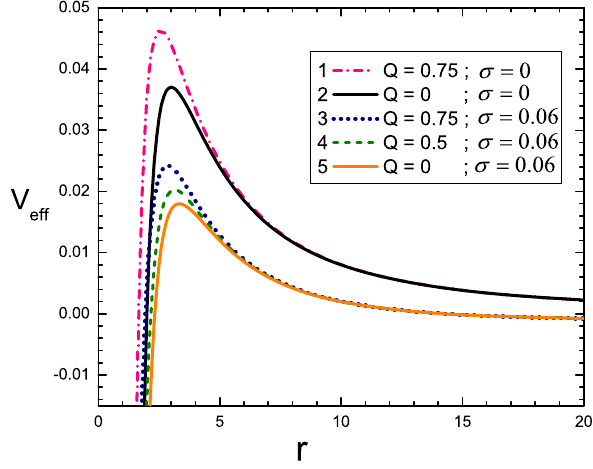
Fig. 3 Effective potential V eff is shown as a function of distance r for non-extreme case at a different values of charge Q with constant value , second curve of quintessence parameter σ . First upper curve for V R eff for V S and fifth curve for V K are taken as a reference. Third and fourth eff eff curves are the non-extreme case of charged Kiselev black hole effective potential V